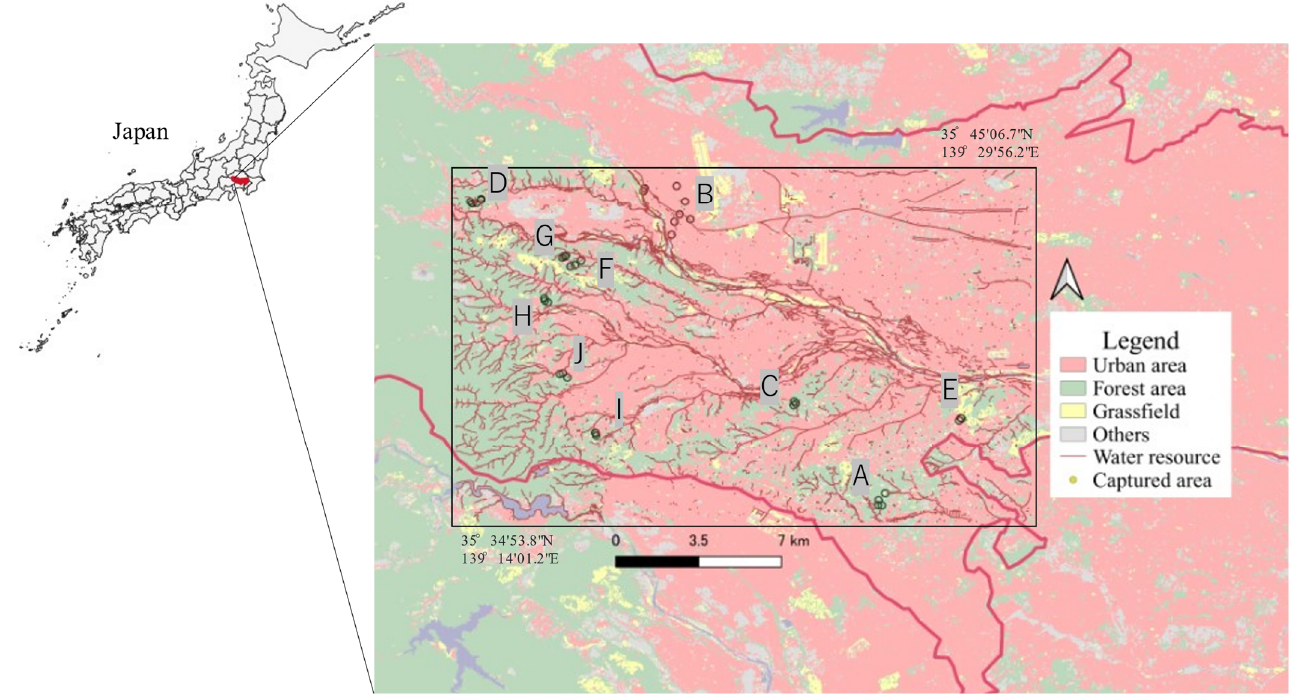
Figure 1. Map of the Tama area, Tokyo, Japan. The study area is marked by the rectangle.